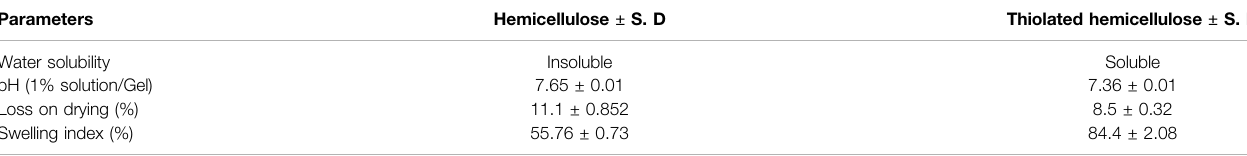
TABLE 2 | Physicochemical properties of Hemicellulose and Thiolated hemicellulose. Parameters Hemicellulose ± S.